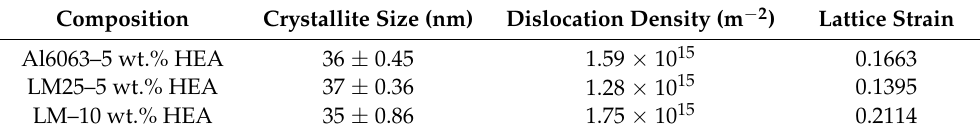
Figure 9. The X-ray diffraction patterns of the Al-based metal matrix composites with various HEA content. Table 1. Crystallite size, dislocation density, and lattice strain values of the Al-based metal matrix composites reinforced with different concentrations of